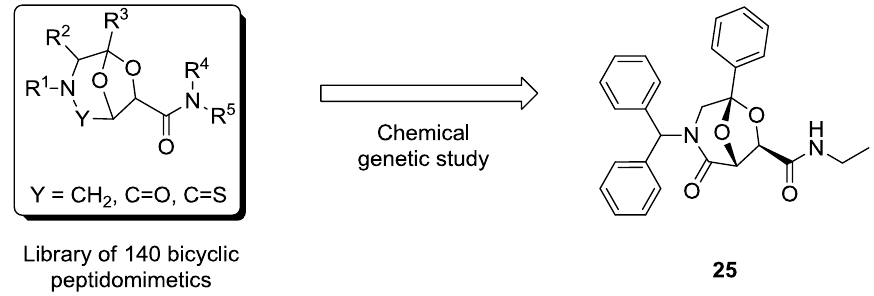
Figure 7. From a library 140 bicyclic peptidomimetics, a forward chemical genetics study allowed for the identification of 25 as a hit antifungal compound